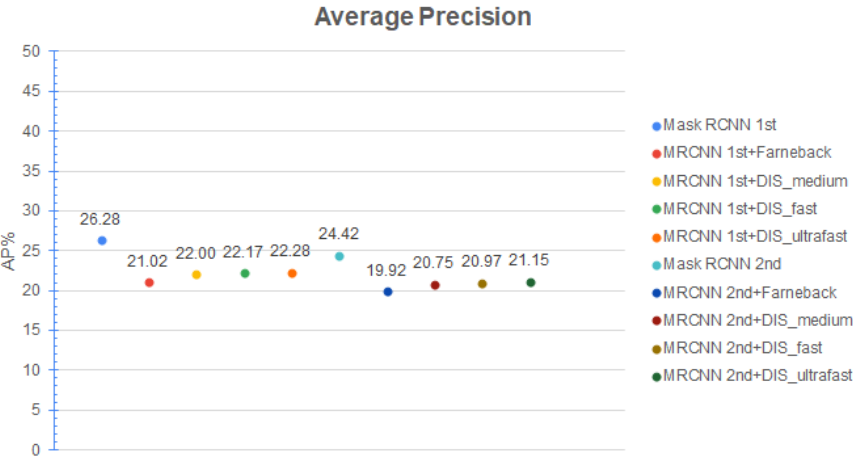
Figure 7. Average Precision, Cityscapes dataset [2].